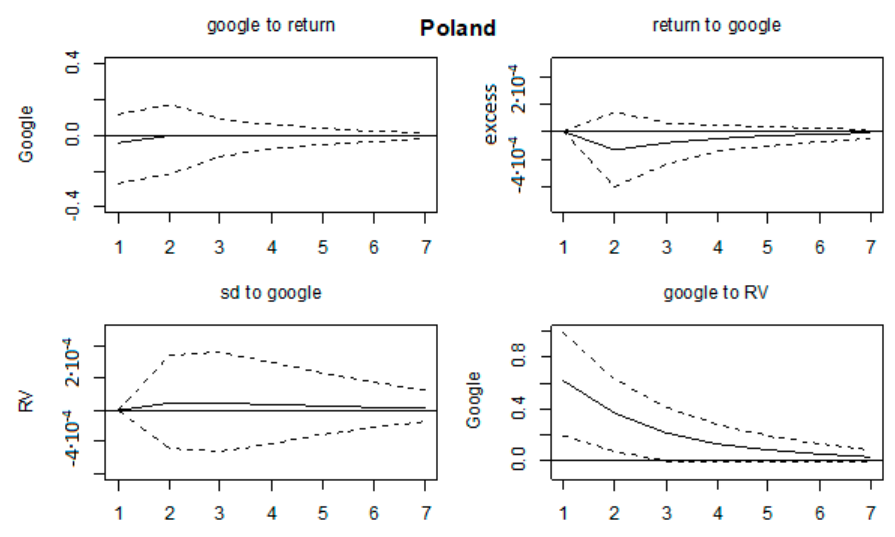
Figure A19. Impulse response functions, Bulgaria.